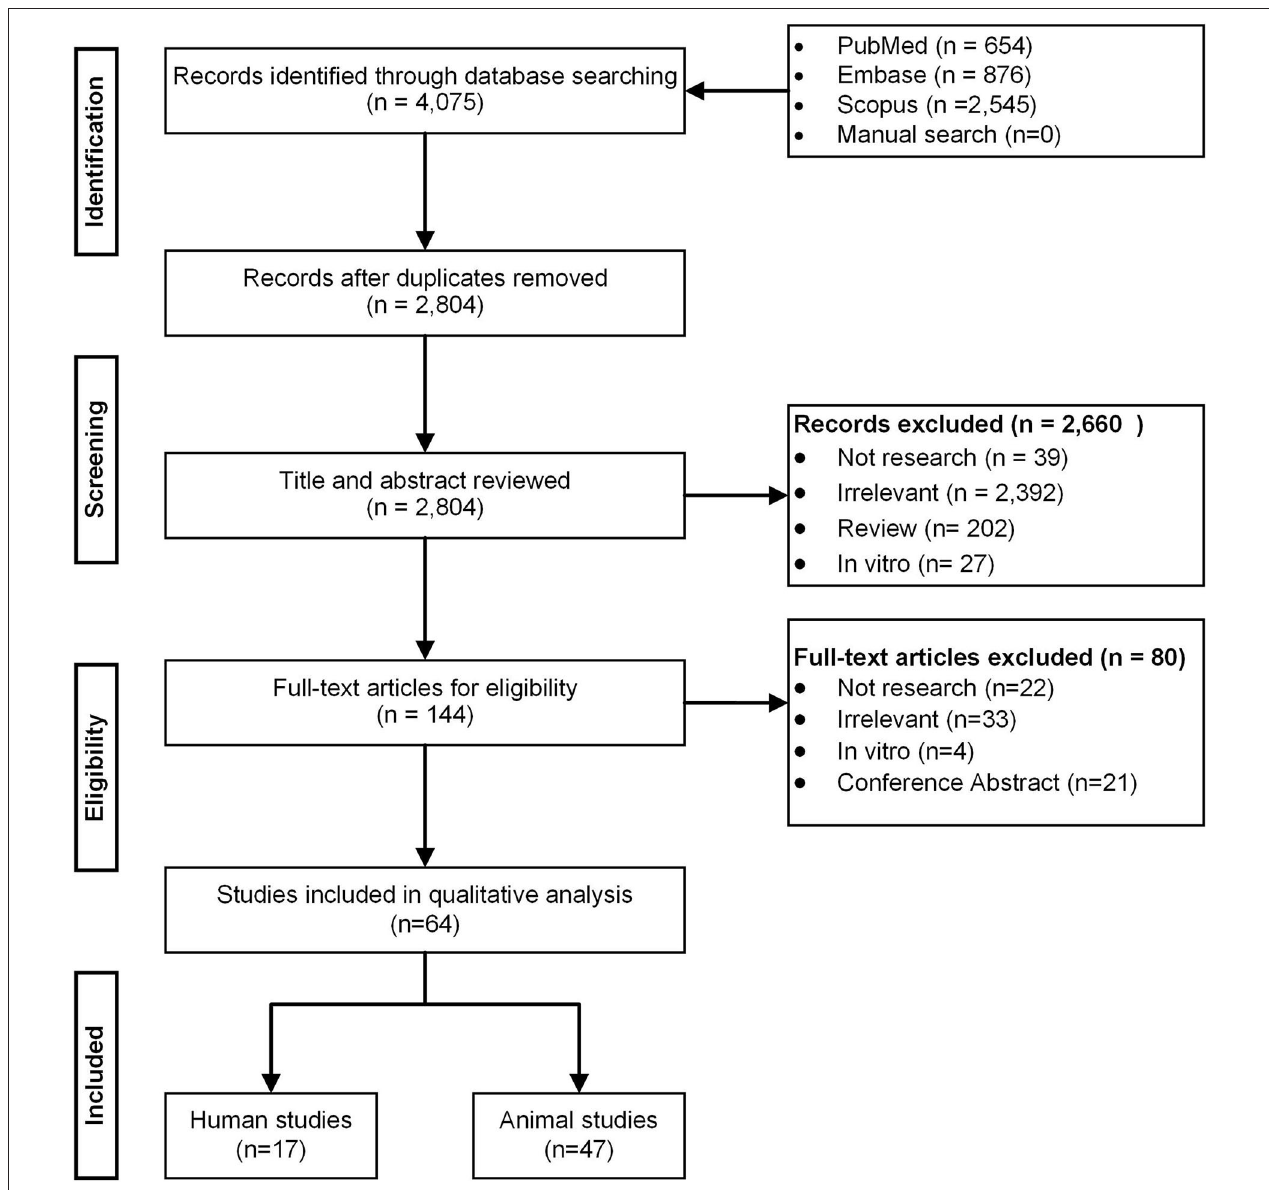
FIGURE 1 | PRISMA flow